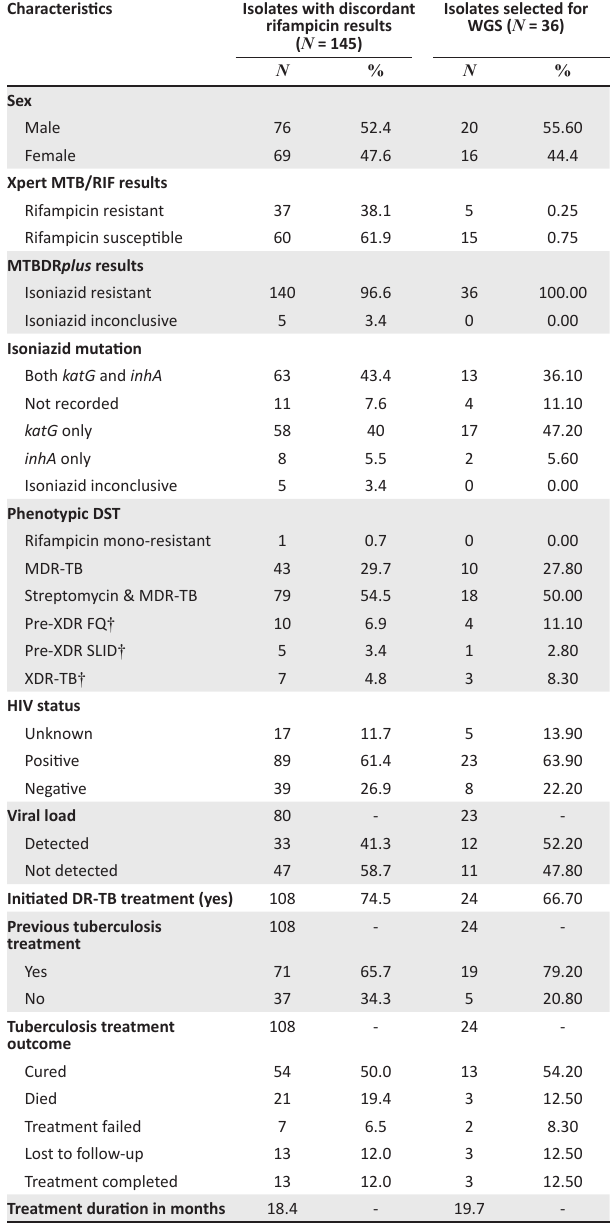
TABLE 1: Patient characteristics of isolates with rpoB gene mutations missed by the Genotype MTBDR plus assay at Inkosi Albert Luthuli Central Hospital Laboratory in KwaZulu-Natal, South Africa between January 2014 and December 2014.